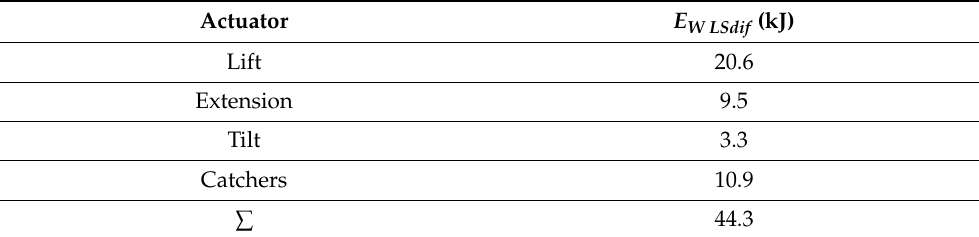
Table 4. Energy dissipated as a result of the load-sensing pressure differential.